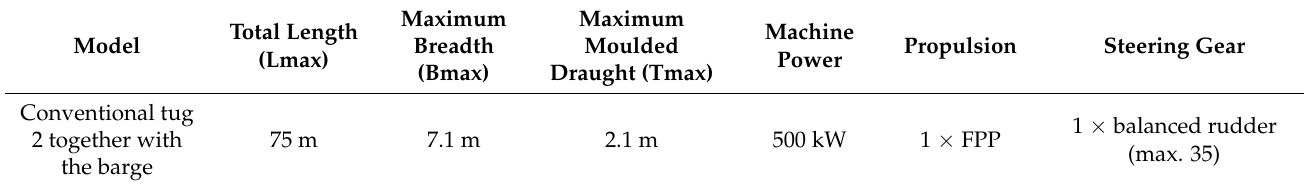
Figure 5. Outline of the model combined with the barge. Table 1. Selected parameters of the model combined with the barge.